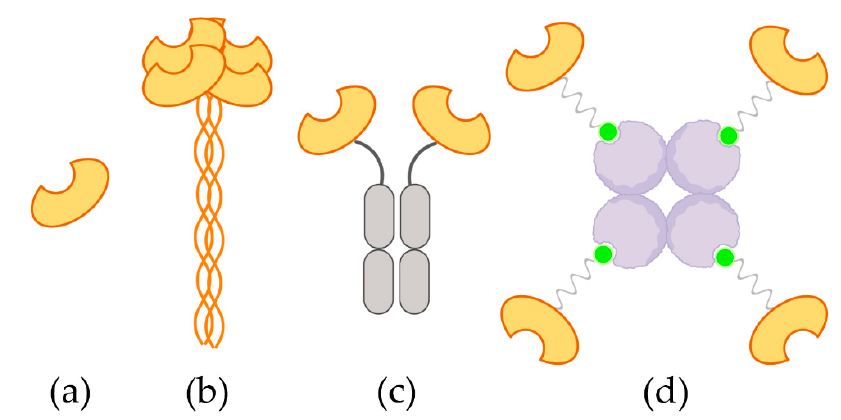
Figure 1. Schematic representation of the four constructs considered in this work. ( a ) Monomeric carbohydrate recognition domain (CRD); ( b ) natural extracellular domains (ECD) tetramer; ( c ) artificial dimeric Fc-CRD and ( d ) artificial tetrameric TETRALEC.